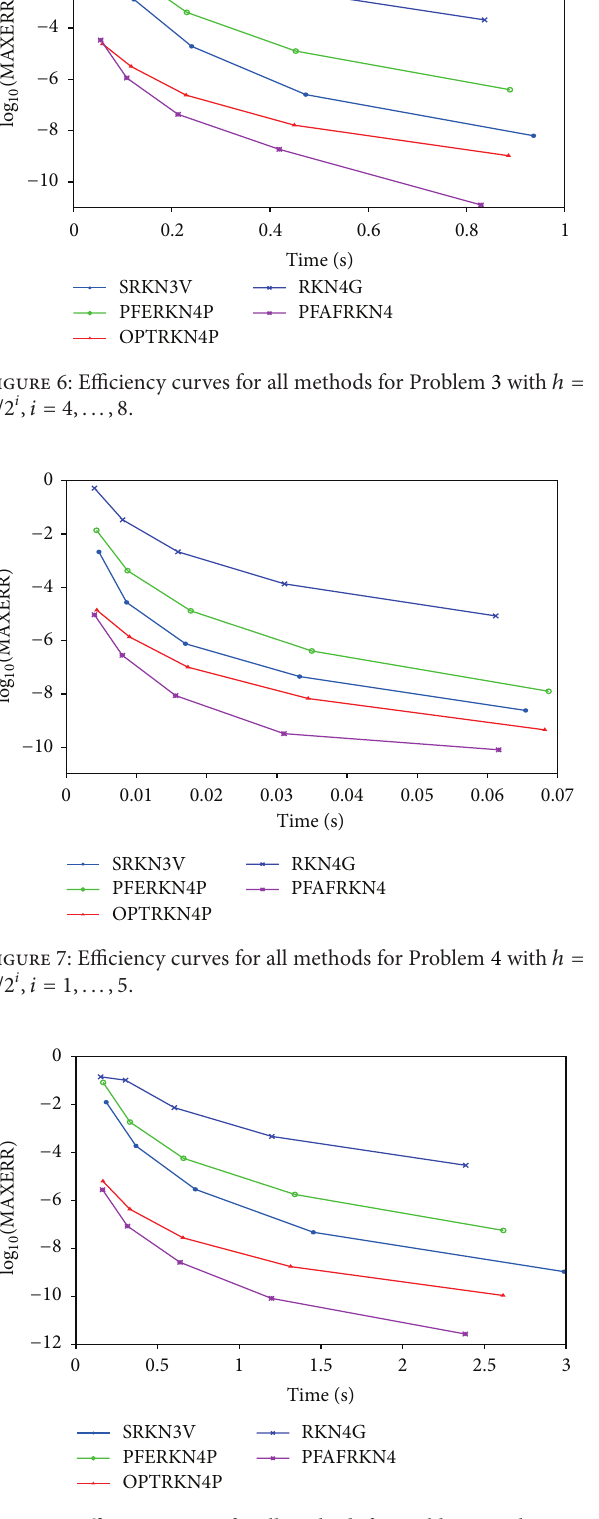
Figure 8: Efficiency curves for all methods for Problem 5 with 𝑡 4000 and ℎ = 1/2 𝑖 , 𝑖 = 5, ...,9 .